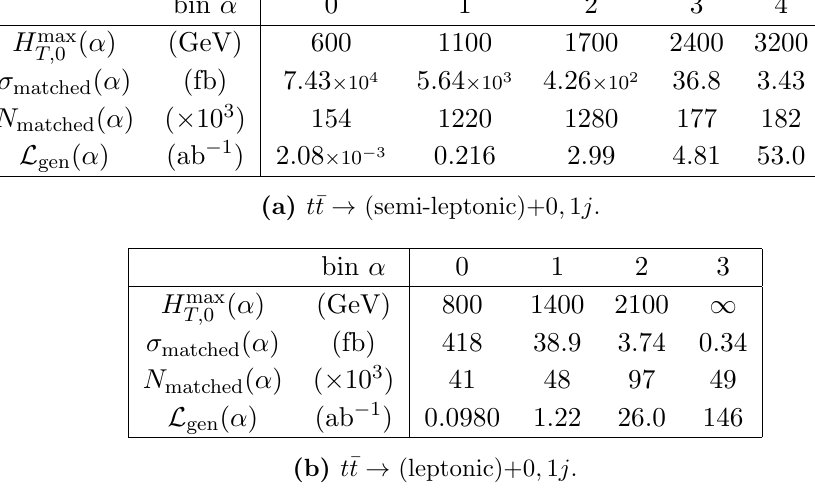
Table 4. Same as in table 2, but for the t (cid:22) t production